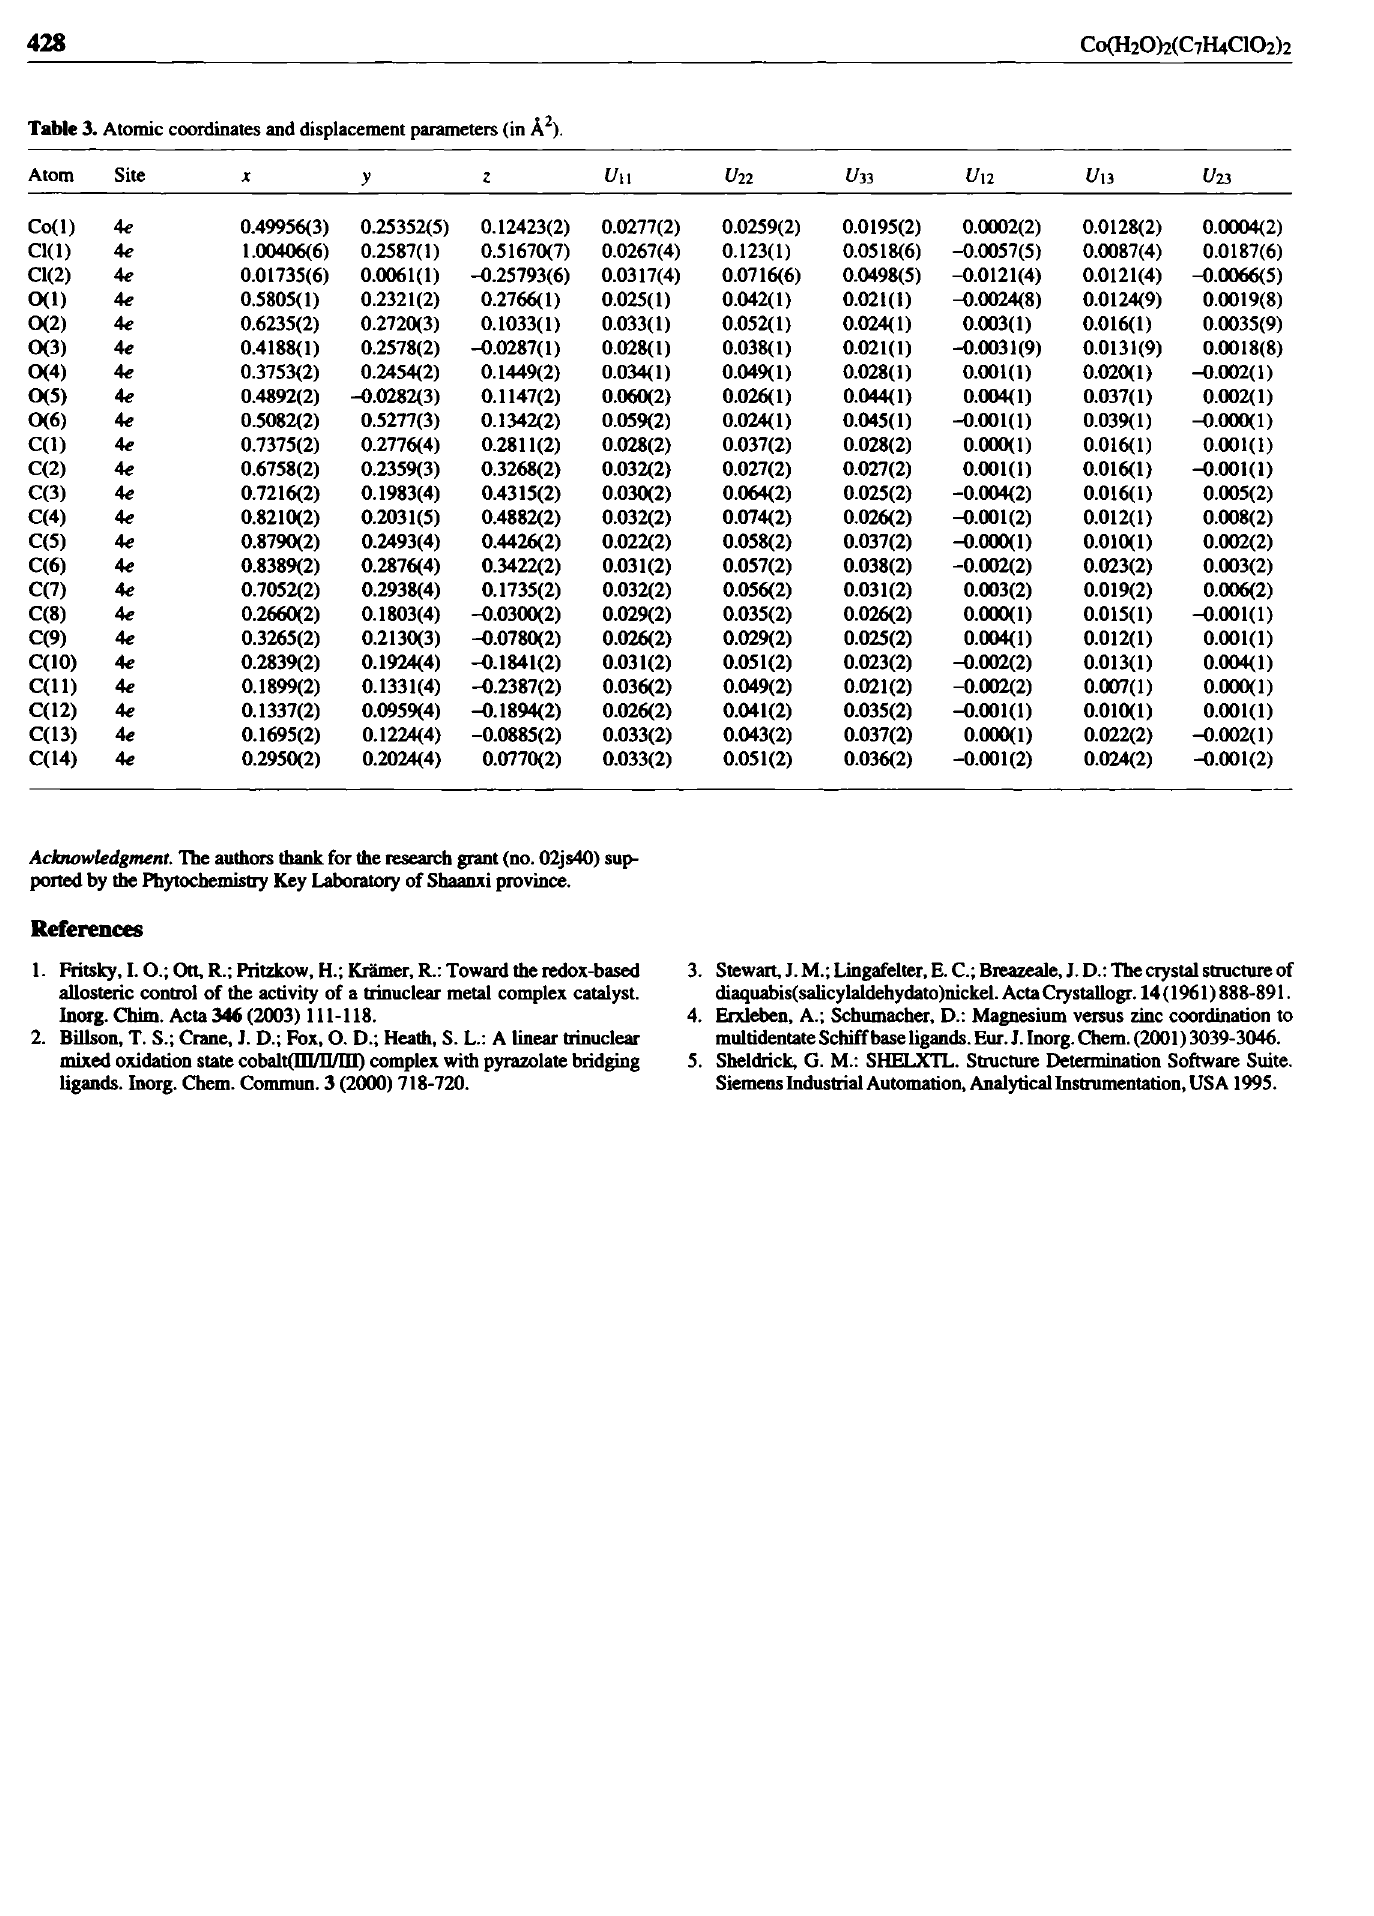
Table 3. Atomic coordinates and displacement parameters (in A 2